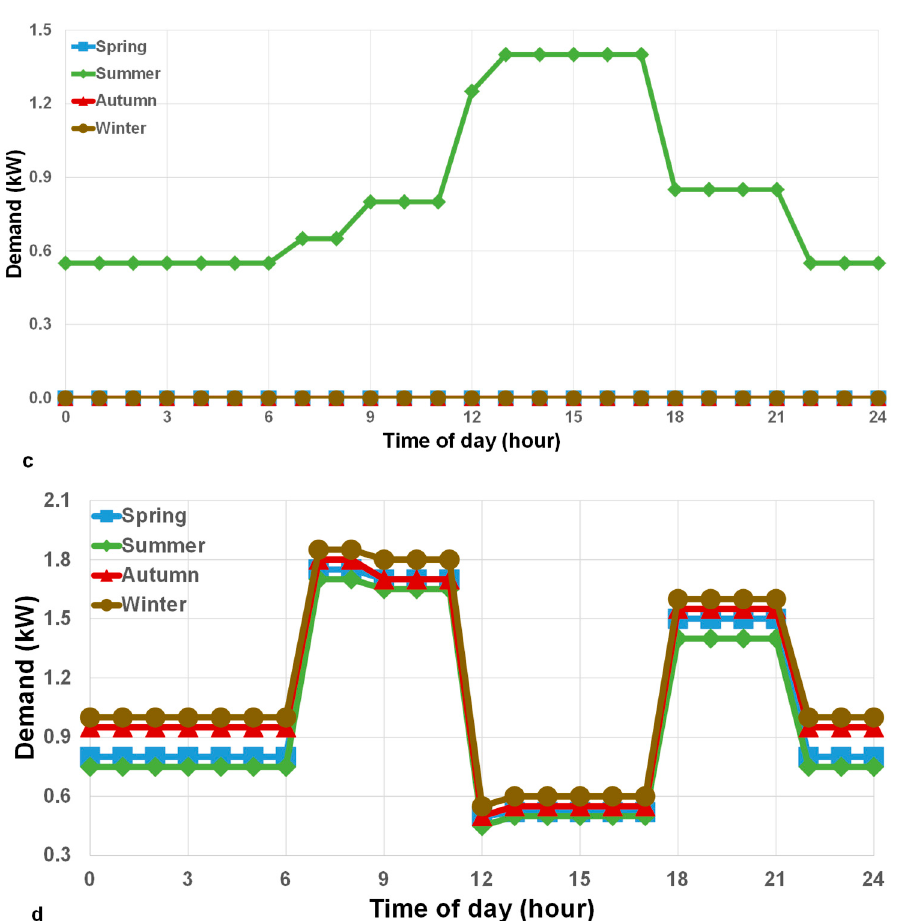
Figure 2. Average demand profiles per household for ( a ) electricity (adapted from [4] and [16]); ( b ) heating (adapted from [4] and [19]); ( c ) cooling (adapted from [17,18]); and ( d ) hot water (adapted from [4] and [19].